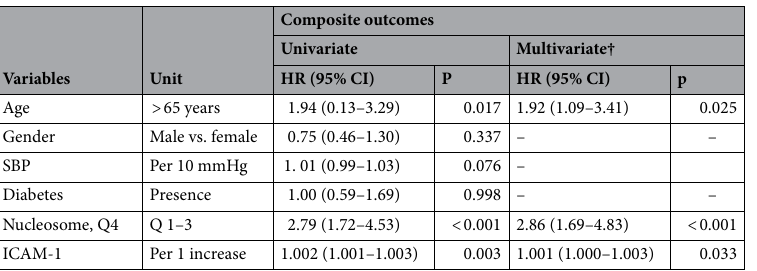
Table 2. Predictors of long-term composite outcomes. † Adjusted for age, gender, blood pressure, diabetes, nucleosome and ICAM-1.